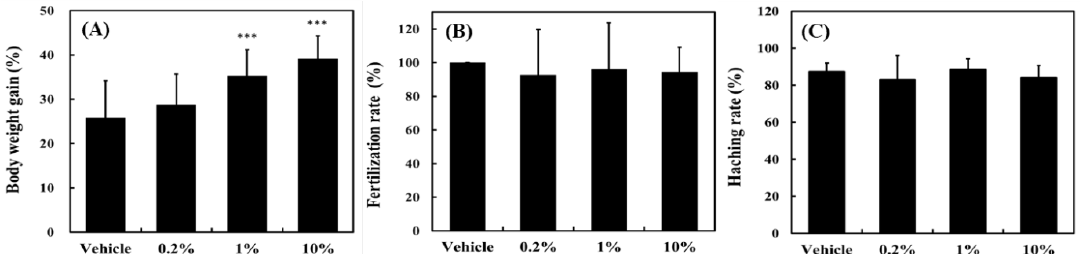
Figure 2. Effect of Antrodia cinnamomea extraction waste (ACEW) supplementation on ( A ) weight gain, ( B ) fertilization rate, and ( C ) hatching rate of zebrafish during 30-day cultivation. For the body weight gain study, thirty adult fish were used in each group and put in the same aquarium. For the reproduction study, three males were paired with three female fish for each group in the mating tank one night before spawning event. Significant difference compared with the vehicle group was denoted as *** p < 0.001. Table 1. Growth performance of zebrafish fed diets supplemented with different doses of ACEW a . Growth Indices